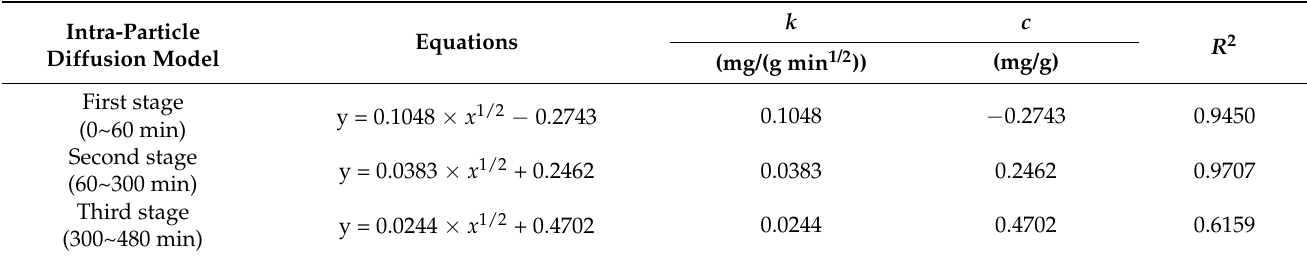
Table 7. Kinetic parameters using the intra-particle diffusion model for the adsorption of ammonium on